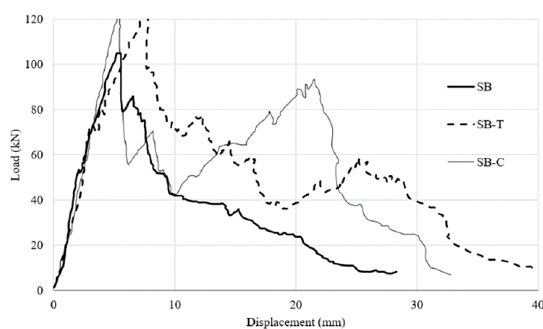
Figure 15. Load–displacement variation for punching of slabs for concrete grade B (SB: control slab; CFRP strengthened slab; and SB-T: TRM strengthened slab) [37].